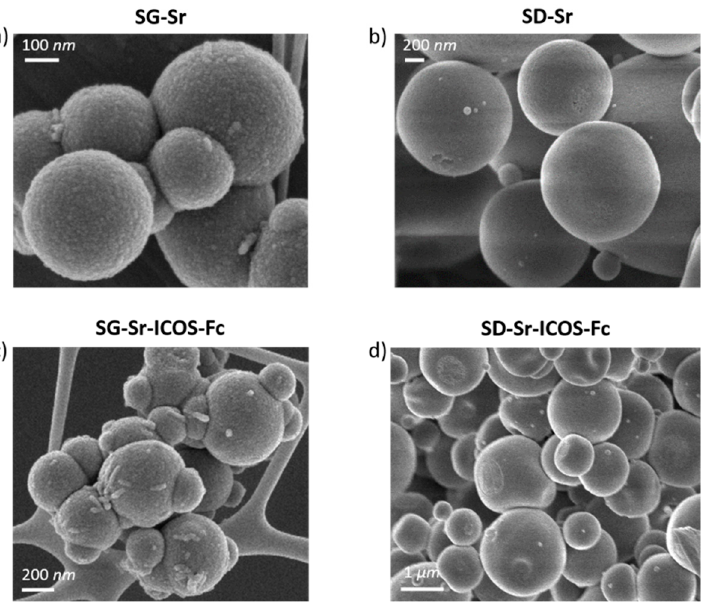
Figure 3. FE-SEM images of SG-Sr ( a ), SD-Sr ( b ), SG-Sr-ICOS-Fc ( c ), and SD-Sr-ICOS-Fc ( d ).